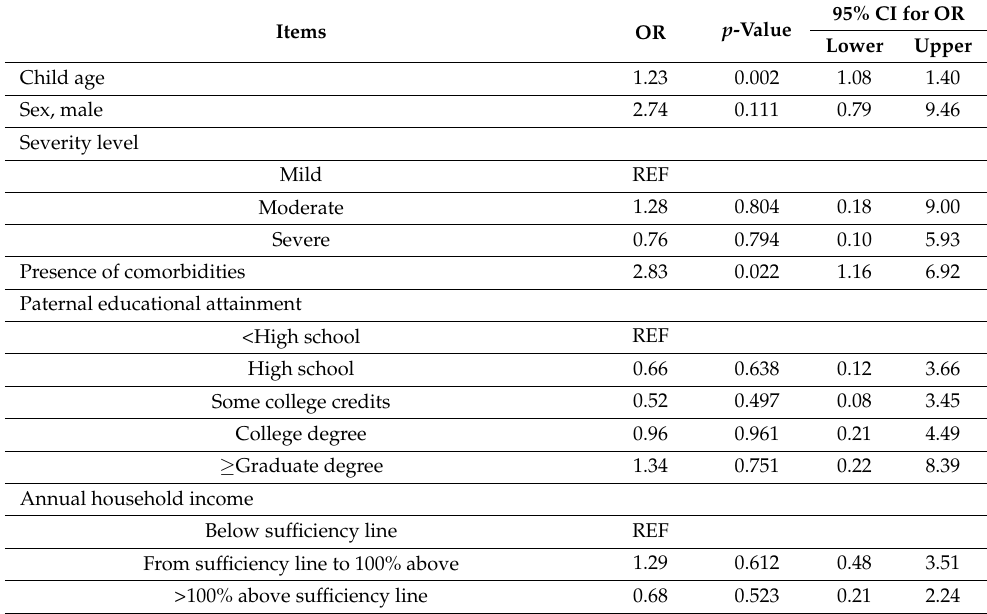
Table 4. Multiple logistic regression for the factors associated with previous use of psychotropic